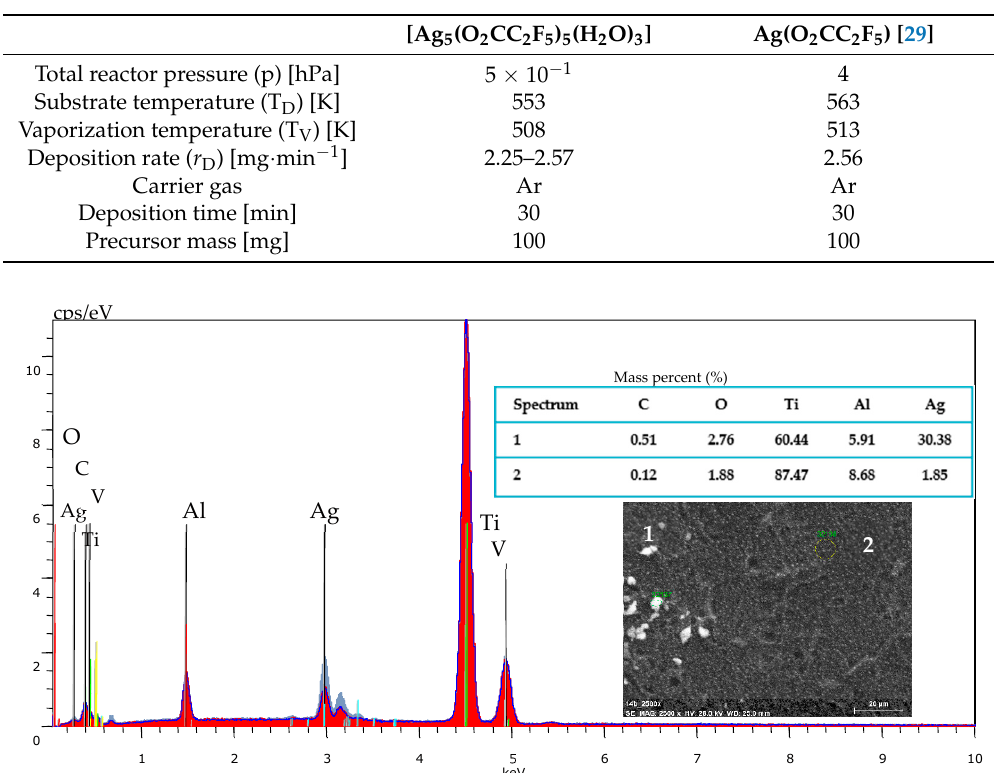
Table 3. Summary of chemical vapor deposition (CVD) conditions for the deposition of silver nanograins.